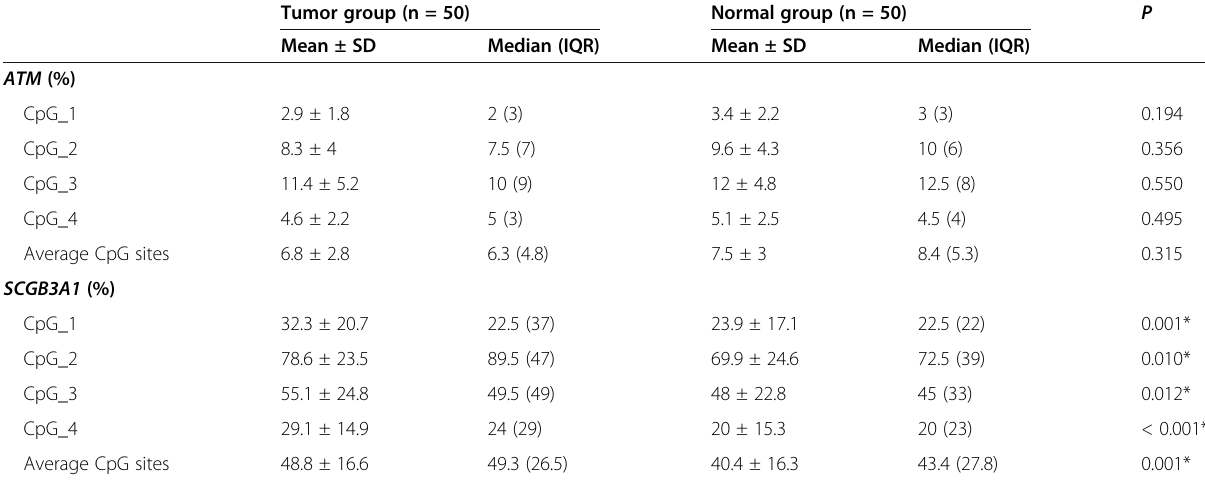
Table 3 DNA methylation percentage of ATM and SCGB3A1 promoters in the studied groups Tumor group (n =